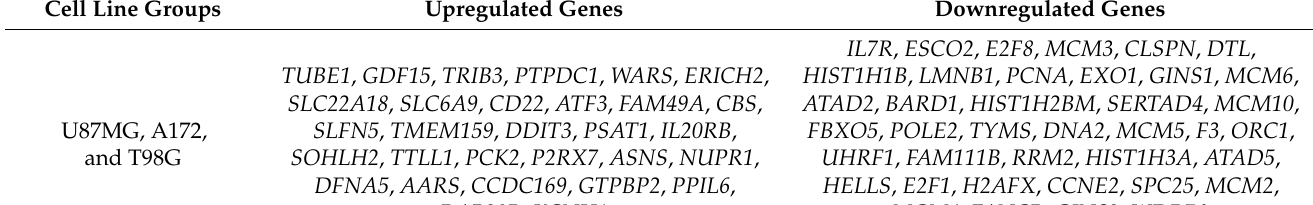
Table 4. Genes modulated by Regorafenib, shared between U87MG, A172, and T98G cells. Cell Line